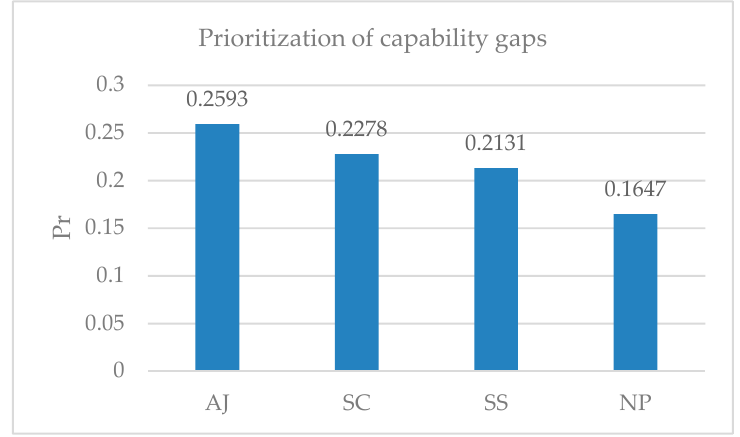
Figure 6. Prioritization of capability gaps.